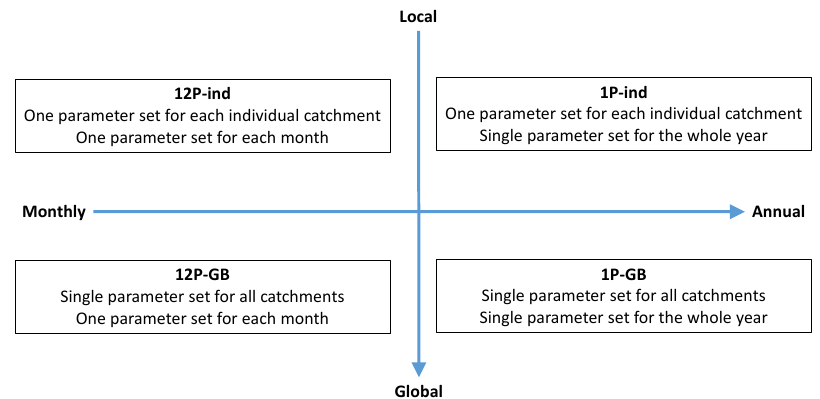
Figure 3. Schematic of the calibration strategies. Four calibration approaches were considered to calibrate the PET equations: from local and monthly parametrisation leading to 12 equations for each of the 43 catchments (12P-ind), to a global parameterisation leading to a single equation for all 43 catchments